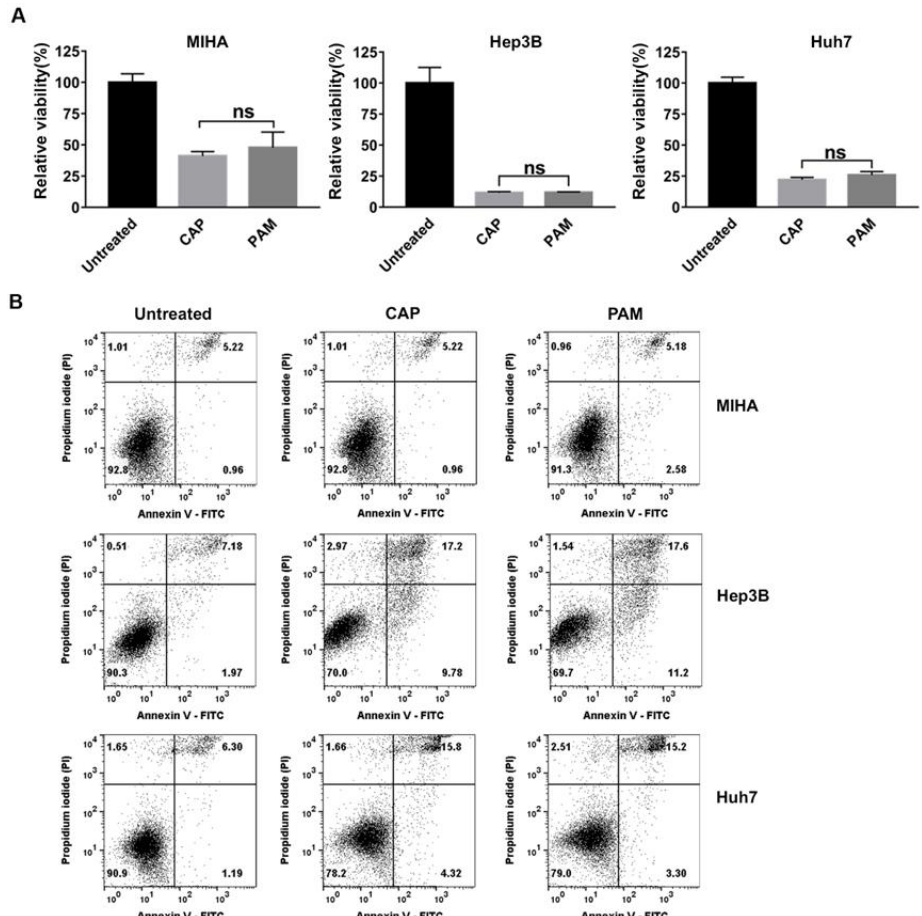
Figure 3. CAP and plasma-activated medium (PAM) showed a highly selective anti-proliferative effect in HCC cells. ( A , B ) For this, 5 × 10 4 MIHA, Hep3B, and Huh7 cells were seeded in 35 mm culture dishes and pre-incubated for 18 h. ( A ) The